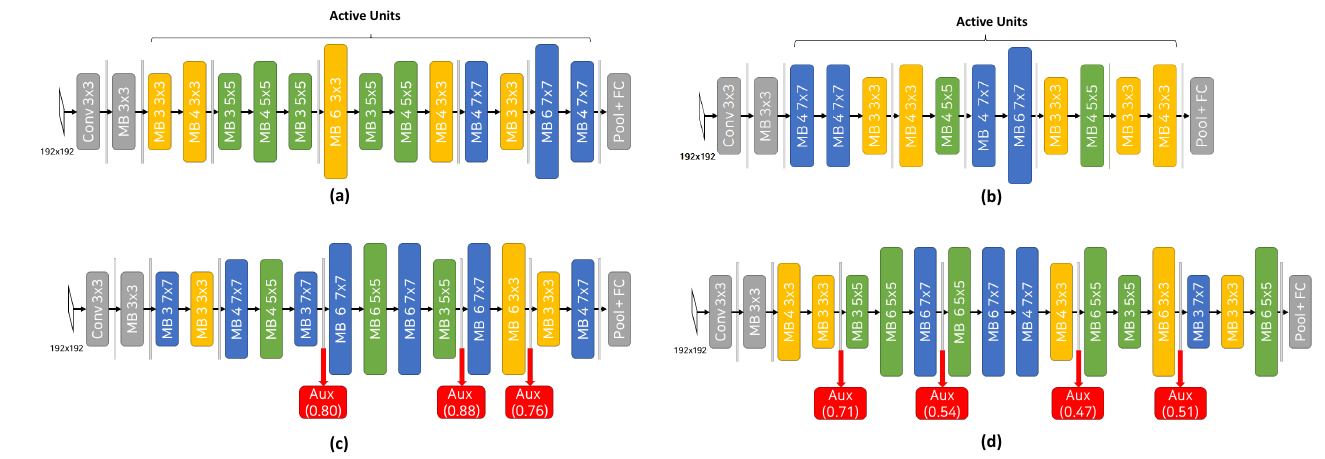
Figure 7. Pareto optimal curves from OFA and CondNAS for CPU and GPU in Galaxy Note 10+, respectively.